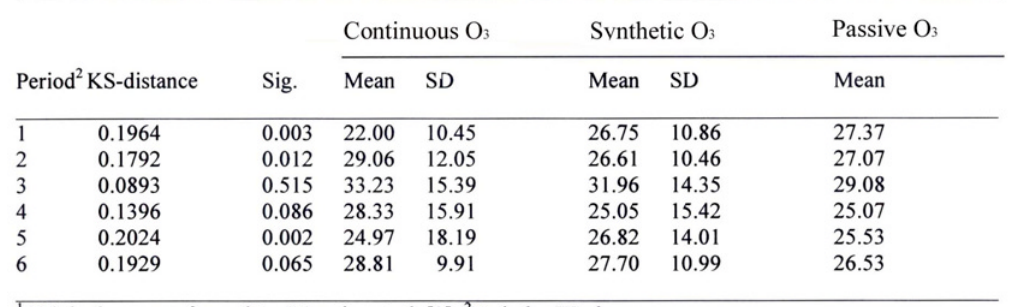
Summary Statistics of the Kolmogorov-Smirnov (KS) Test for Goodness of Fit Between Continuously Monitored and Synthetic Data 1 on Hourly O